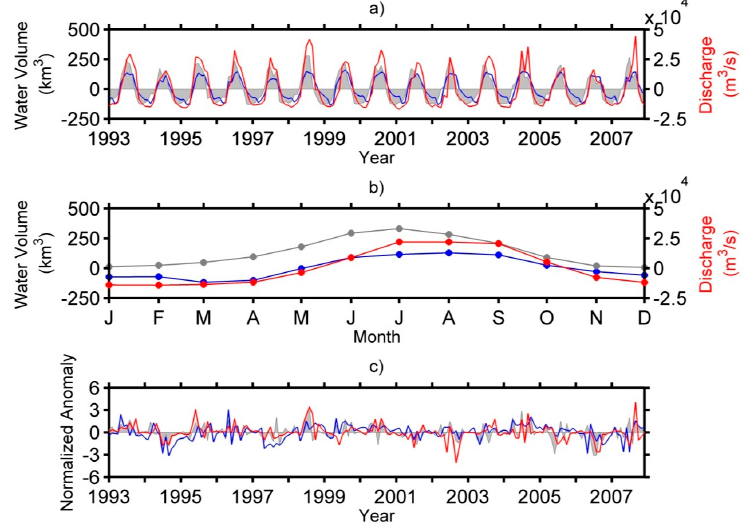
Figure 9. Surface water storage (blue) time series comparison with precipitation (gray) and discharges (red) over the Brahmaputra catchment: ( a ) Annual variations; ( b ) Mean seasonal cycle; ( c ) Inter-annual variations.